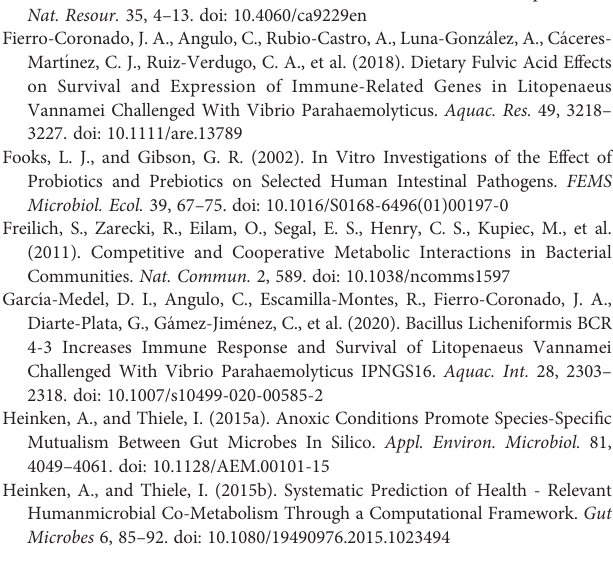
Supplementary Figure 1 | In silico growth rate of 193 species on 15 different nutrient environments. Supplementary Figure 2 | In silico growth rate of Vibrio harveyi on 15 different nutrient environments. Supplementary Figure 3 | Heat map representing the in silico growth of V. harveyi QT520 in a pairwise community across 15 different nutrient environments. Supplementary Figure 4 | Interaction types exhibited by 48 species under 15 different nutrient environments. Red represents the maximum number of environments in which organisms present different types of interaction. Supplementary Figure 5 | In silico nutrient uptake by screened 48 species in pairwise community models. Supplementary Figure 6 | Barplot representing metabolic gains achieved by single and paired species. Supplementary Figure 7 | Phylogenetic tree of 16S rRNA gene of screened species generated using maximum likelihood method in MEGA 7.0 with bootstrap set to